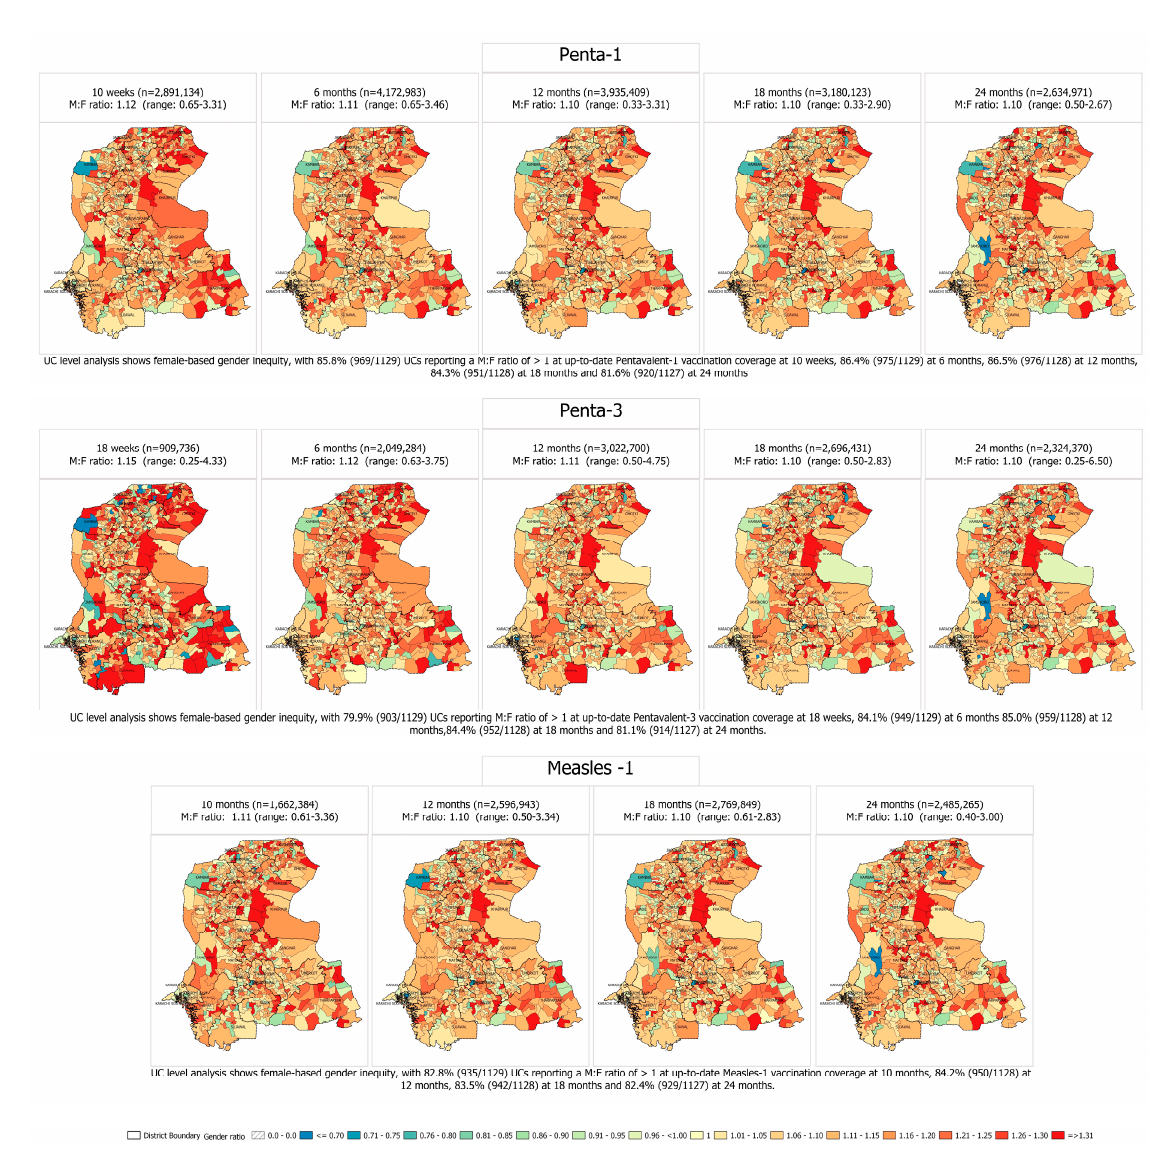
Figure 1. Male-to-female ratios of up-to-date vaccination coverage of Pentavalent-1 at 10 weeks and 6, 12, 18, and 24 months; Pentavalent-3 at 18 weeks and 6, 12, 18, and 24 months; and Measles-1 at 10, 6, 12, 18, and 24 months, in 0–23-month-old children in 2019–2022 birth cohorts enrolled in SEIR